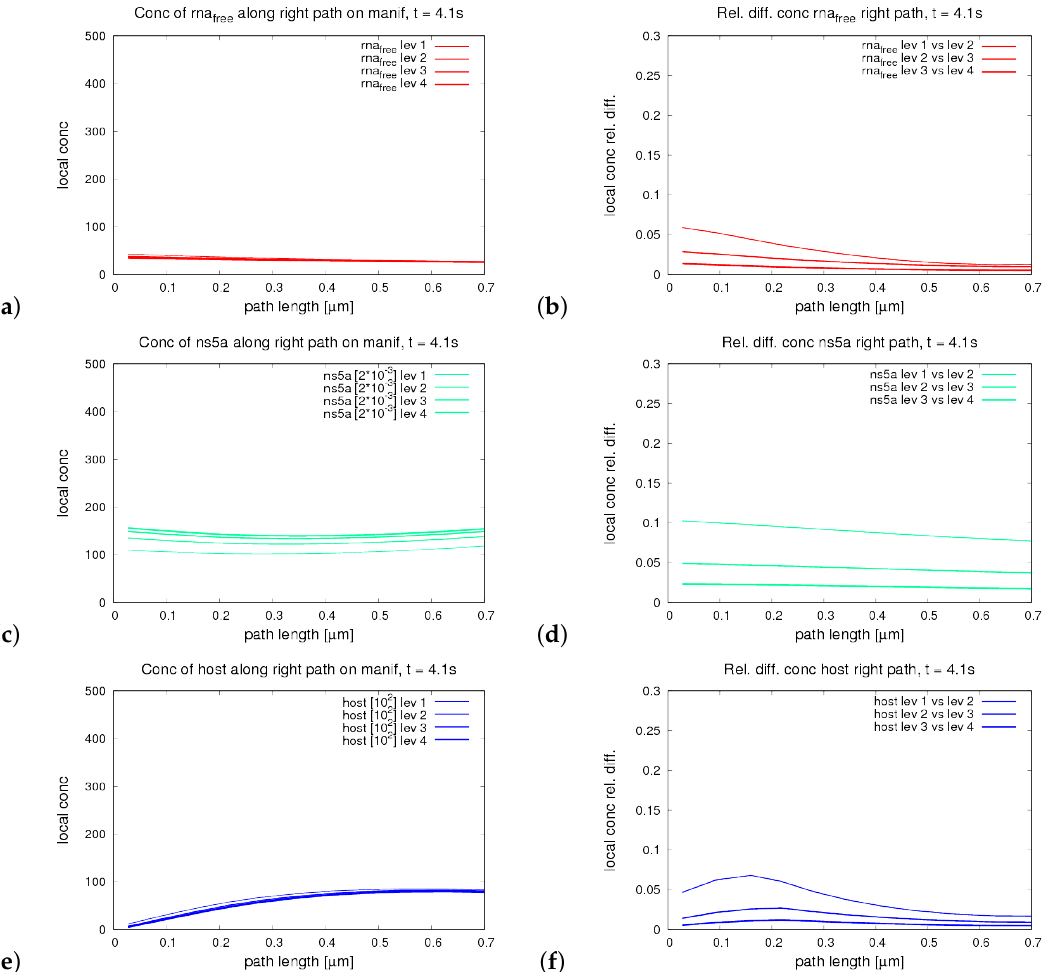
Figure A3. Variation of spatial refinement level for the 1D profiles of the concentrations around a web region. Right sub path. ( a ) Free RNA absolute values for different grid levels, ( b ) Free RNA relative differences for different grid levels, ( c ) NS5a absolute values, ( d ) NS5a relative differences, ( e ) host factor absolute values, ( f ) host factor relative